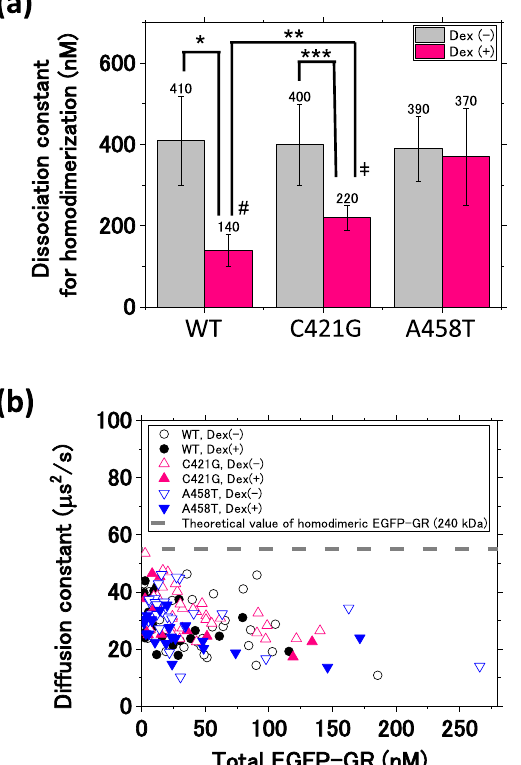
Figure 3. Summary of the dissociation constants of GR homodimerization and complex formation with endogenous interacting proteins. ( a ) A summary of the K d,homo of GR/WT and mutants in the absence (grey bars) and presence (red bars) of Dex. GR/WT in the absence of Dex ( K d,homo : 420 ± 120 nM) and presence of Dex ( K d,homo : 140 ± 40 nM). GR/C421G in the absence of Dex ( K d,homo : 400 ± 100 nM) and the presence of Dex ( K d,homo : 220 ± 30 nM). GR/A458T in the absence of Dex ( K d,homo : 390 ± 80 nM) and the presence of Dex ( K d,homo : 370 ± 120 nM). Bars report averages ± SE. Statistical analysis was performed using Student’s t -test combined with the jackknife resampling method. * p = 7 × 10 − 8 , ** p = 0.003, *** p = 3 × 10 − 6 , # p = 4 × 10 − 10 , ǂ p = 7 × 10 − 5 . ( b ) A summary of diffusion constants of wild-type GR and GR mutants in the absence and presence of Dex. Black open circle: GR/WT in the absence of Dex (N = 28); black solid circle: GR/WT in the presence of Dex (N = 25); red open triangle: GR/C421G in the absence of Dex (N = 35); red solid triangle: GR/C421G in the presence of Dex (N = 14); blue open triangle: GR/A458T in the absence of Dex (N = 28); blue solid triangle: GR/ A458T in the presence of Dex (N = 21); grey dashed line: theoretical diffusion constant (55 μ m 2 /s) calculated from the molecular weight of homodimeric EGFP-GR (240 kDa). Nearly all diffusion constants were between 10 and 47 μ m 2 /s, which correspond to 470 kDa to 43